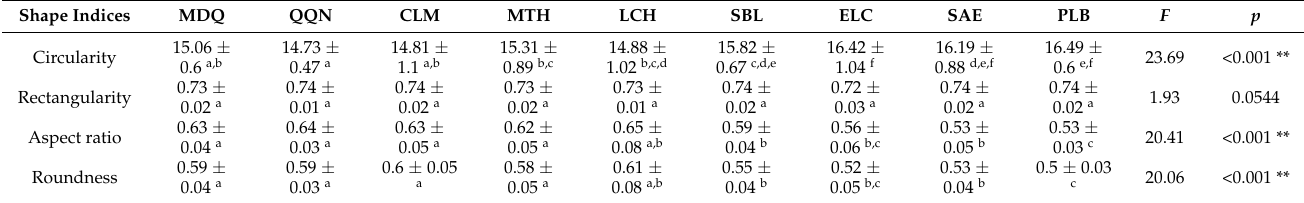
Table 2. Median values ± standard deviation of shape indices by locality, (ANOVA statistical analysis: F [statistic] and p [significance]). MDQ: Mar del Plata; QQN: Quequ é n; CLM: Claromec ó ; MTH: Monte Hermoso; LCH: La Chiquita; SBL: San Blas; ELC: El C ó ndor; SAE: San Antonio Este; PLB: Puerto Lobos.